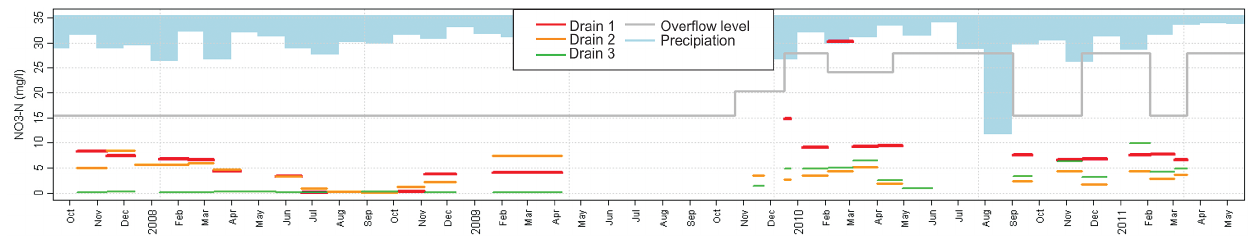
levels was measured. During the second controlled drainage period the groundwater levels dropped slightly, which is compensated for in the water balance with a positive volume ( + 26